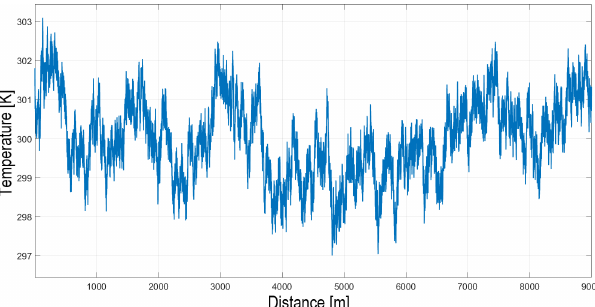
Figure 6. Spatial temperature signal in CBL conditions after converting the time-series data given a constant wind speed of 10ms − 1 .